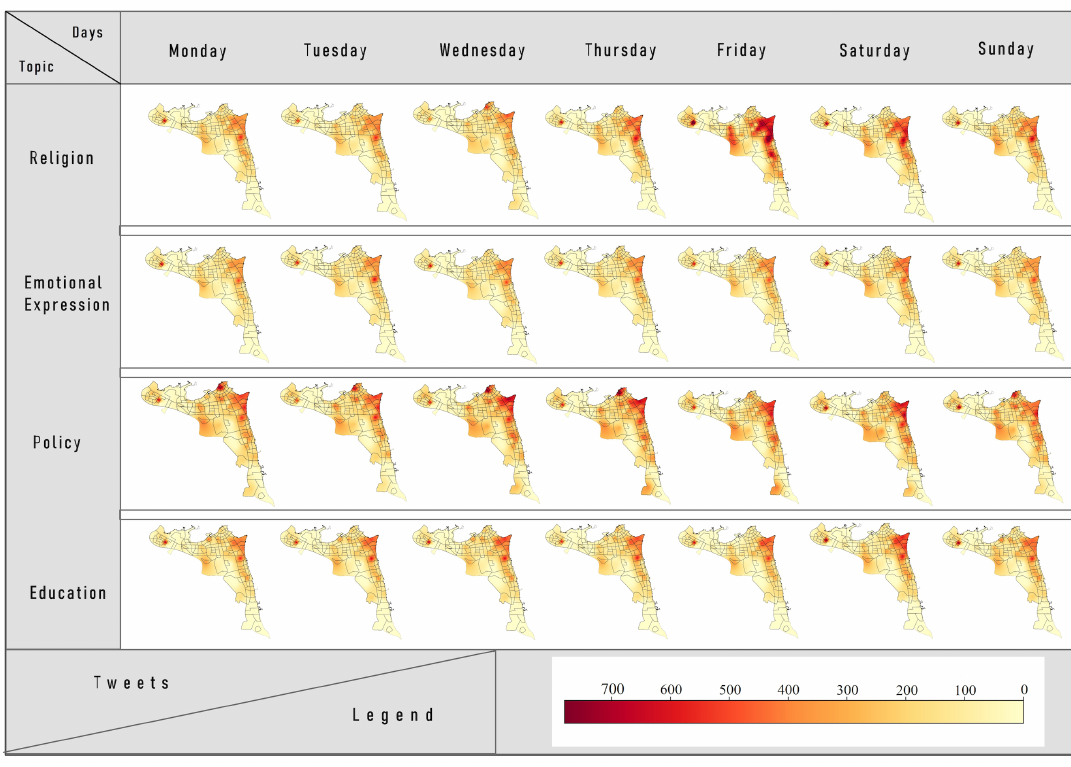
Figure 10. The spatial distribution of top topics of interest across week